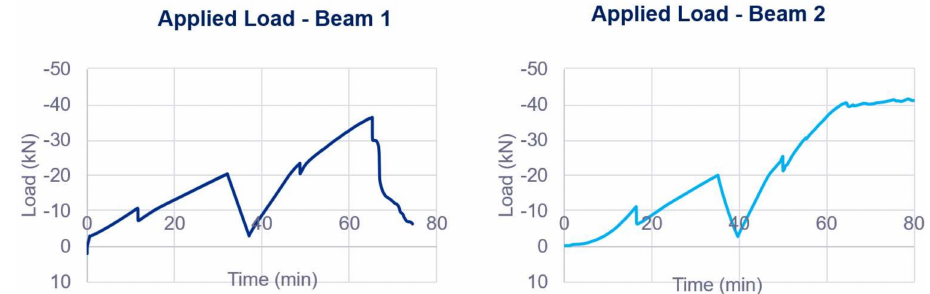
Figure 10. Applied load to each beam specimen.